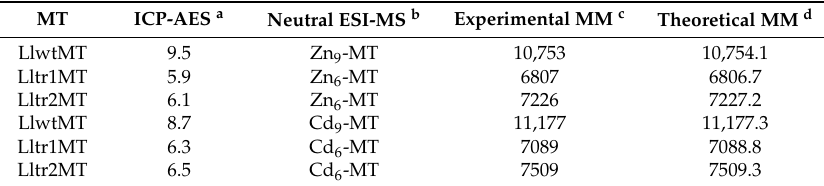
Figure 3. Deconvoluted Electrospray Ionization Mass Spectrometry (ESI-MS) spectra of the recombinant preparations of ( A ) LlwtMT; ( B ) Lltr1MT; and ( C ) Lltr2MT, purified from bacterial cultures grown under Zn-supplementation and analyzed at acid pH (2.4). Table 1. Analytical characterization of the recombinant Zn- and Cd-complexes of LlwtMT, Lltr1MT, and Lltr2MT.